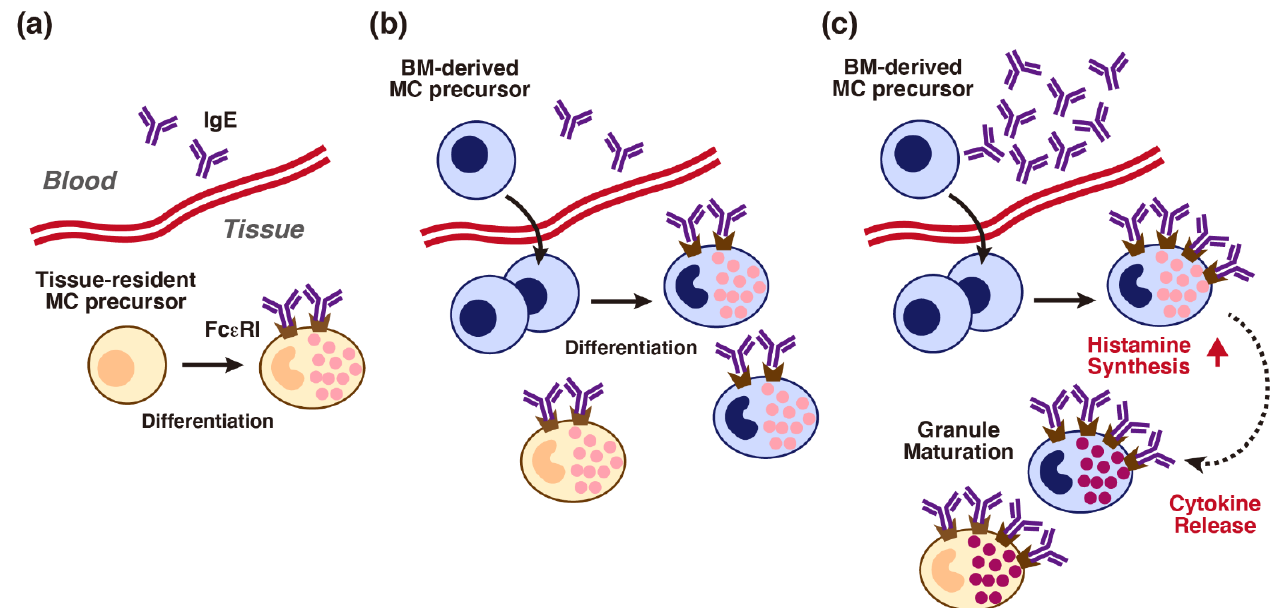
Figure 3. Possible effects of immunoglobulin E (IgE) on local maturation of tissue mast cells. ( a ) Accumulating evidence suggests that local tissue mast cell populations are maintained through the differentiation of the tissue-resident mast cell (MC) precursors. ( b ) Bone marrow-derived MC precursors are infiltrated from the circulation upon inflammation. Such MC precursors might be differentiated in response to the environmental factors. ( c ) Higher concentrations of IgE might induce up-regulation of surface Fc ε receptor I (Fc ε RI) and monomeric IgE effects on infiltrated immature mast cells. An IgE-induced transient increase in histamine synthesis and autocrine/paracrine effects of released cytokines may enhance granule maturation of immature mast cells (dark colored